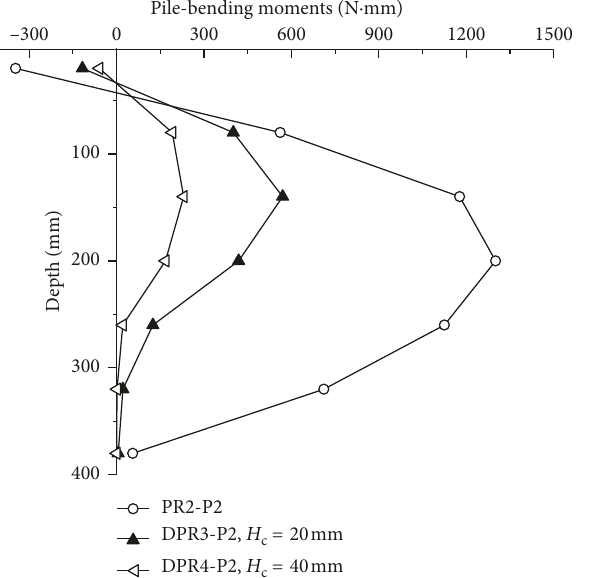
Figure 8: Influence of vertical loading on the lateral responses of the pile bending moments under a 300 N horizontal